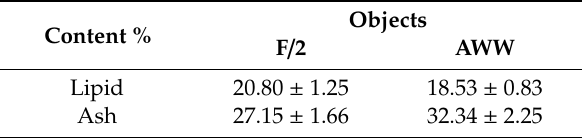
Lipid and ash content of microalgal biomass (mean ± SD; F / 2—synthetic medium, AWW—aquaculture wastewater).